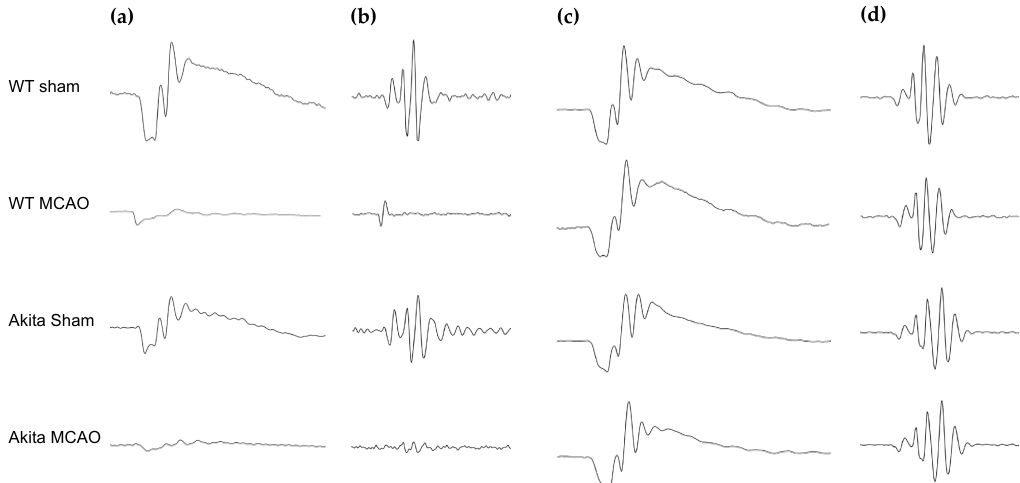
Figure 1. Representative waveforms of scotopic flash ERG responses in WT and Akita mice after sham or MCAO treatment for 2I2R ( a , b ) and 2I22R ( c , d ) groups at 3 cd.s/m² intensity. ( a ) a-wave and b-wave waveforms for 2I2R group; ( b ) oscillatory potential waveforms for 2I2R group; ( c ) a-wave and b-wave waveforms for 2I22R group; ( d ) oscillatory potentials waveforms for 2I22R group. Figure and caption has been adapted from a dissertation [9]. Please refer to acknowledgements section.